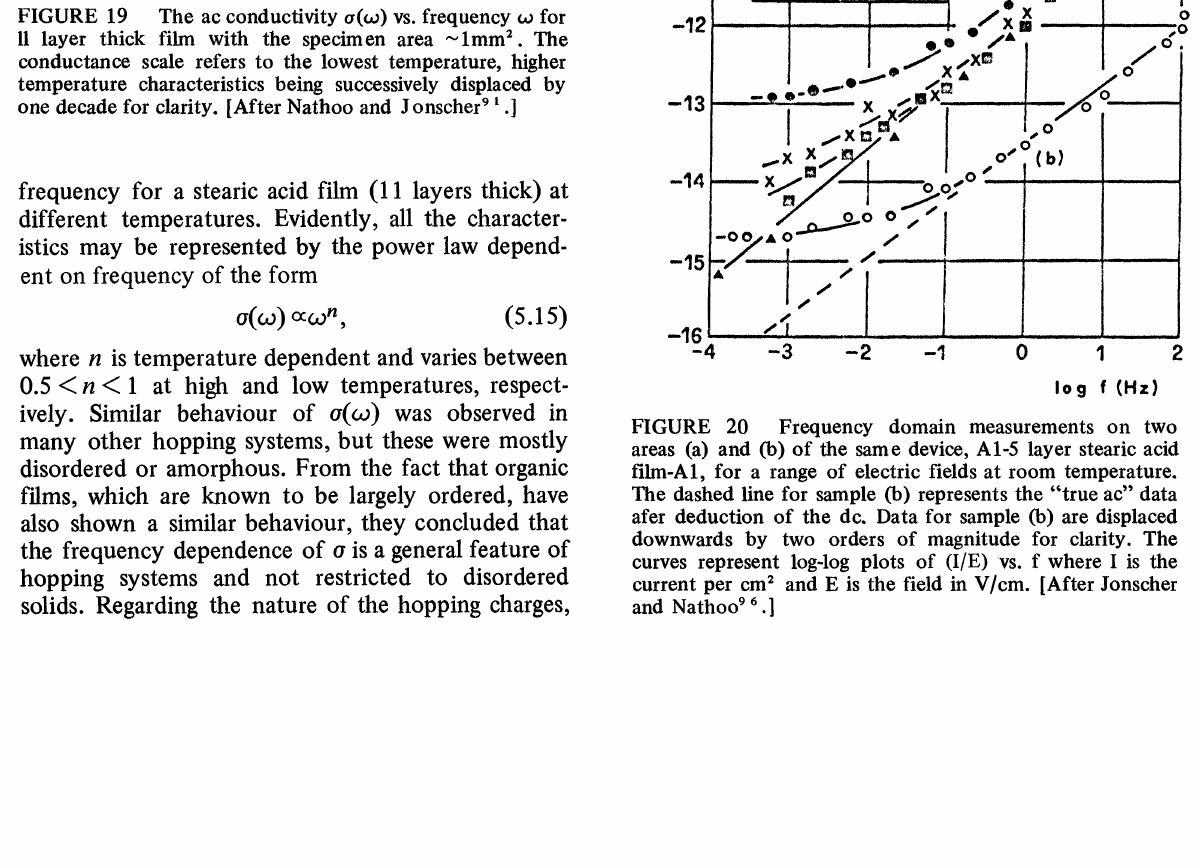
FIGURE 19 The ac conductivity a(o) vs. frequency for II layer thick film with the specben area ~lmm The conductance scale refers to the lowest temperature, higher temperature characteristics being successively displaced by one decade for clarity. [After Nathoo and J onscher